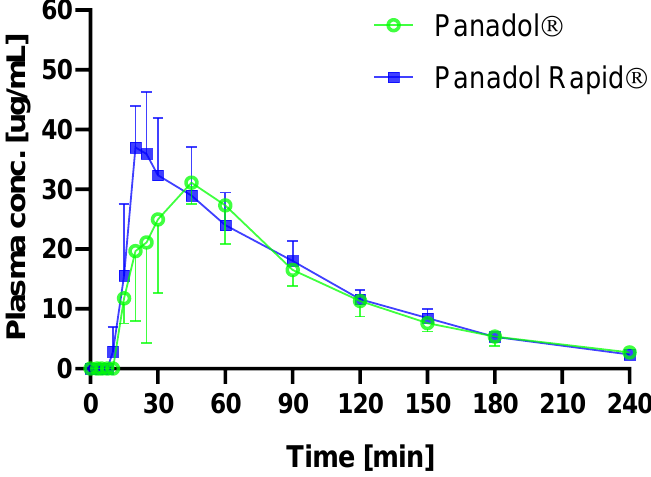
Figure 5. Plasma concentration of paracetamol in beagle dogs after oral administration of Panadol (o) and Panadol rapid ( ■ ) (mean ± standard deviation, n = 3). Table 2. Summary of pharmacokinetic variables (mean ± 95% confidence interval, n = 3). Data